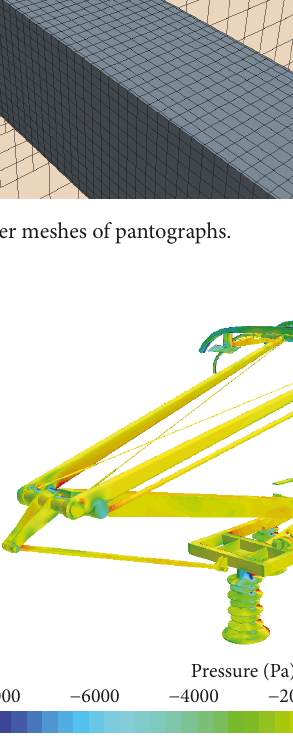
Figure 6: Contours of surface pressures.